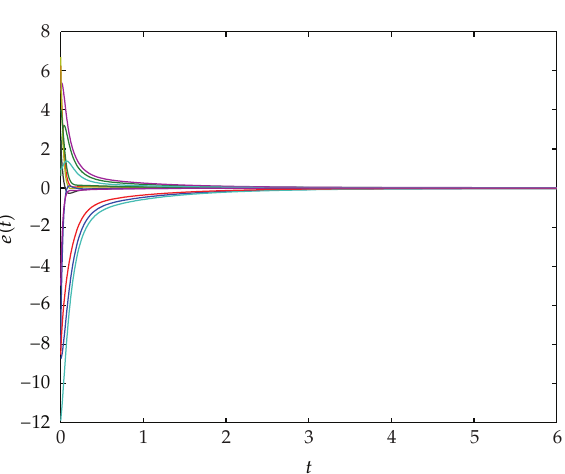
Figure 3: the error response e (cid:6) t (cid:7) between the position x (cid:6) t (cid:7) and its estimate (cid:13) x (cid:6) t (cid:7) for fractional-order α (cid:8) 0 . 9.